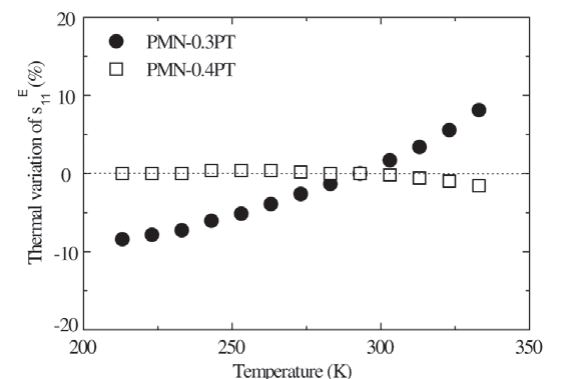
Figure 3. Thermal variation of the elastic constant s 0.3PT and PMN-0.4PT